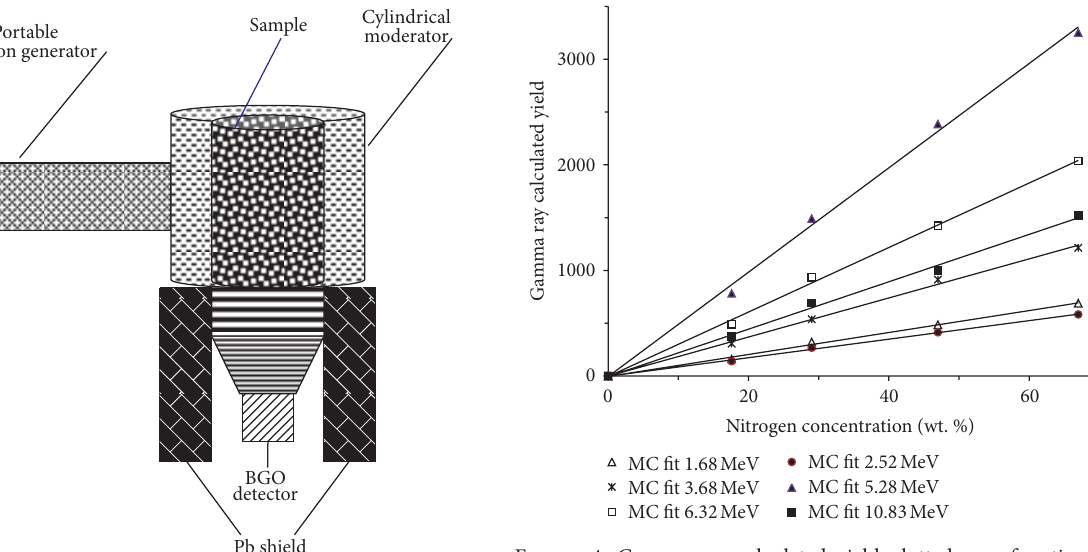
Figure 4: Gamma ray calculated yield plotted as a function of nitrogen concentration of caffeine, disperse orange, melamine, and urea samples obtained through Monte Carlo